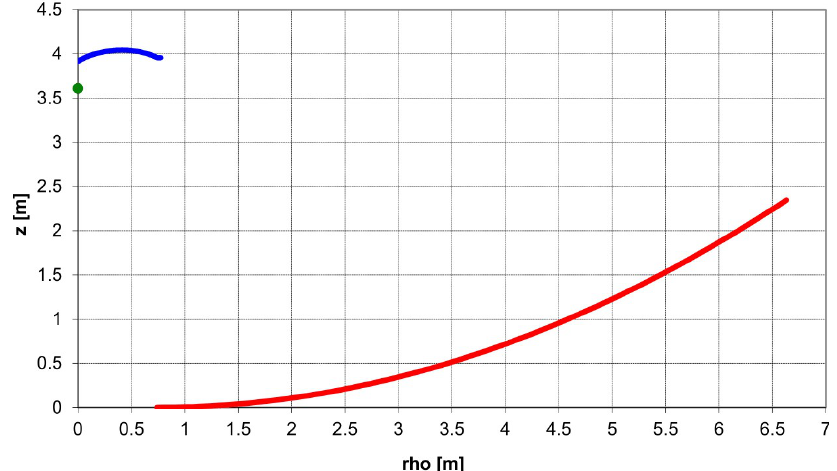
Figure 3. RAEGE radio telescope reflector